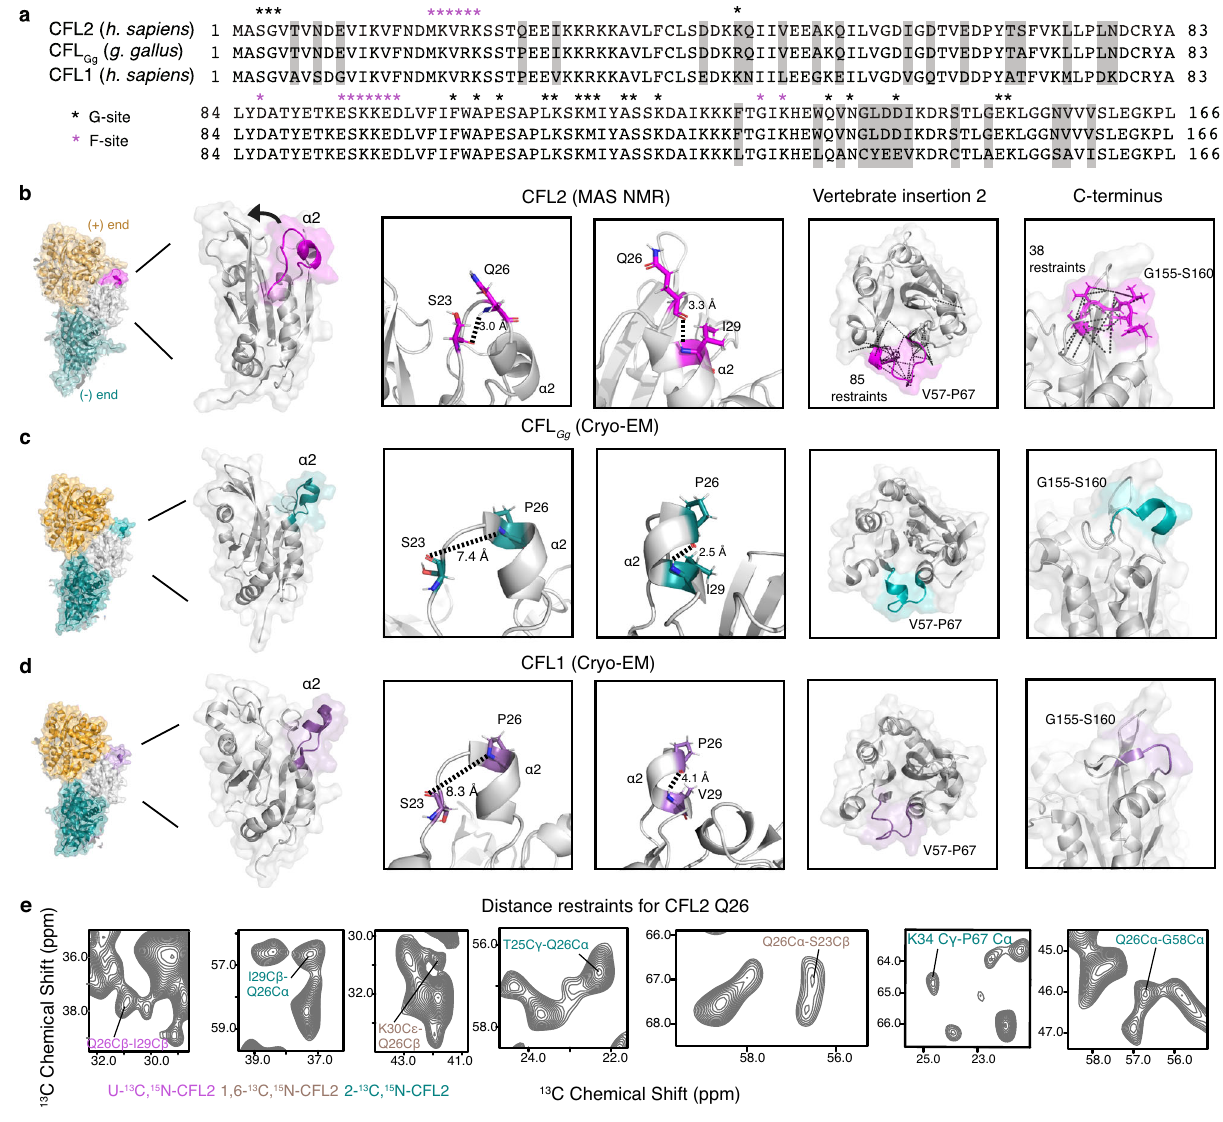
Fig. 2 CFL2 exhibits conformational changes compared to other isoforms. a Sequence alignment of CFL2, CFL Gg , and CFL1. Non-conserved residues are indicated by gray shading. The canonical G-site (black) and F-site (magenta) binding sites are indicated by asterisks. b – d Left panels: Ribbon structures of CFL2 (pink, PDB ID: 7M0G), CFL Gg (teal, PDB ID: 5YU8), and CFL1 (purple, PDB ID: 6VAO). Orientations of CFL isoforms bound between adjacent actin protomers (orange and teal) in the fi lament are shown. In each structure, the NLS containing α 2 is indicated. CFL2 undergoes a 30° rotation of α 2 which is not observed in other structures. Middle two panels: Expansions of α 2 for CFL2 (magenta), CFL Gg (teal), and CFL1 (purple). In CFL2, the P26Q substitution induces a remodeling of the hydrogen-bonding network in α 2 that is responsible for the rotation. Right two panels: Regions corresponding to vertebrate insertion 2 and the C-terminal region for CFL2 (magenta), CFL Gg (teal), and CFL1 (purple). The region containing vertebrate insertion 2 is structurally coupled to α 2. For CFL2, this region is de fi ned by 85 unique C-C restraints, represented on the structure with black dashed lines. The conformation of the C-terminal region of CFL2 is similar to CFL1 but exhibits more disorder compared to CFL Gg . For CFL2, this region is de fi ned by 38 unique C-C restraints, represented on the structure with black dashed lines. e Unambiguous MAS NMR distance restraints containing Q26 and α